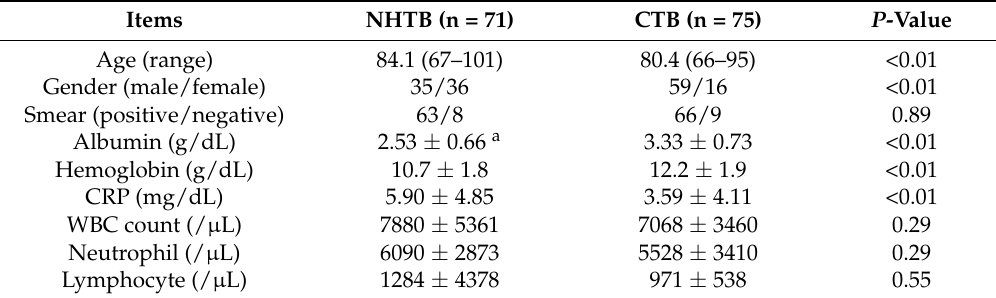
Table 2. Baseline characteristics and laboratory data of patients with NHTB and CTB.